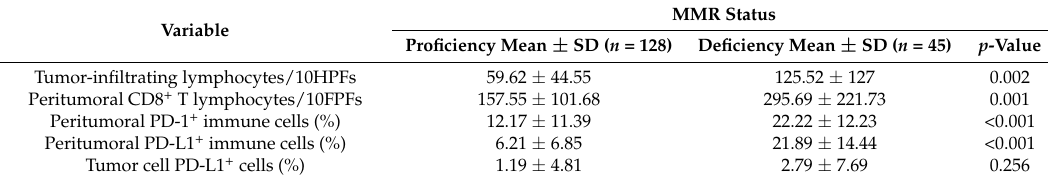
Table 3. Comparison of the tumor-infiltrating lymphocytes (TIL) count, CD8 + T lymphocyte count, and to DNA mismatch repair (MMR) status and probable Lynch syndrome (PLS) (versus sporadic